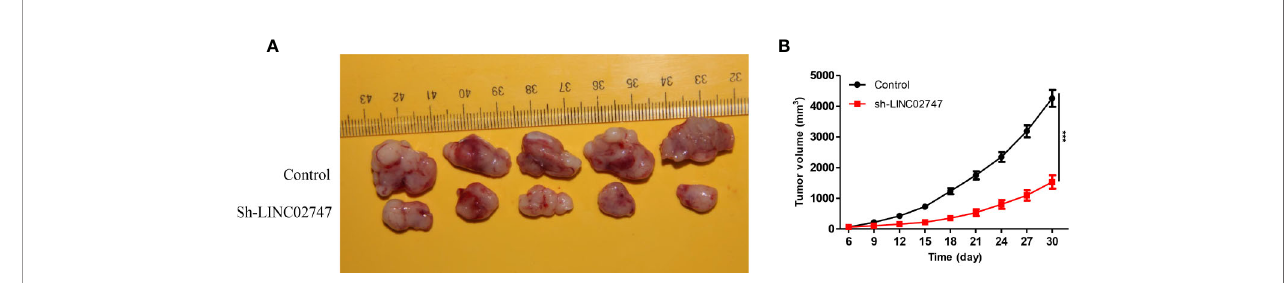
FIGURE 4 | (A) Tumors collected from the control and sh-LINC02747groups for 30 days in vivo . (B) Growth curves of the Control and sh-LINC02747. (*** P < 0.001, ** P < 0.01, * P